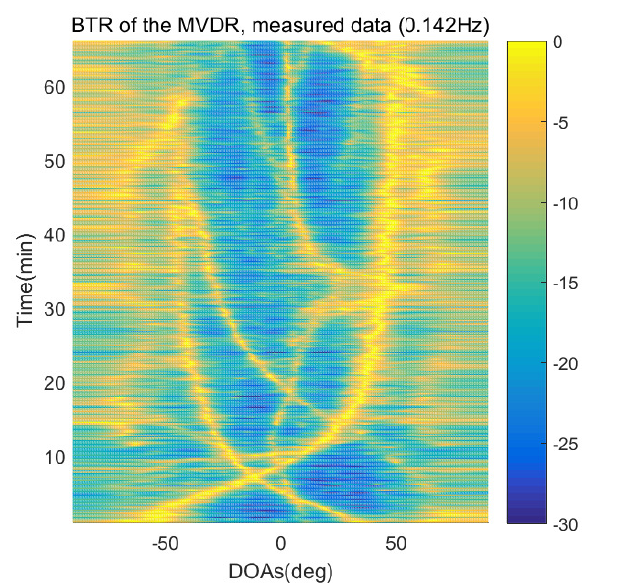
Figure 19. Bearing time records of the MVDR: 66 min, signal frequency = 0.142